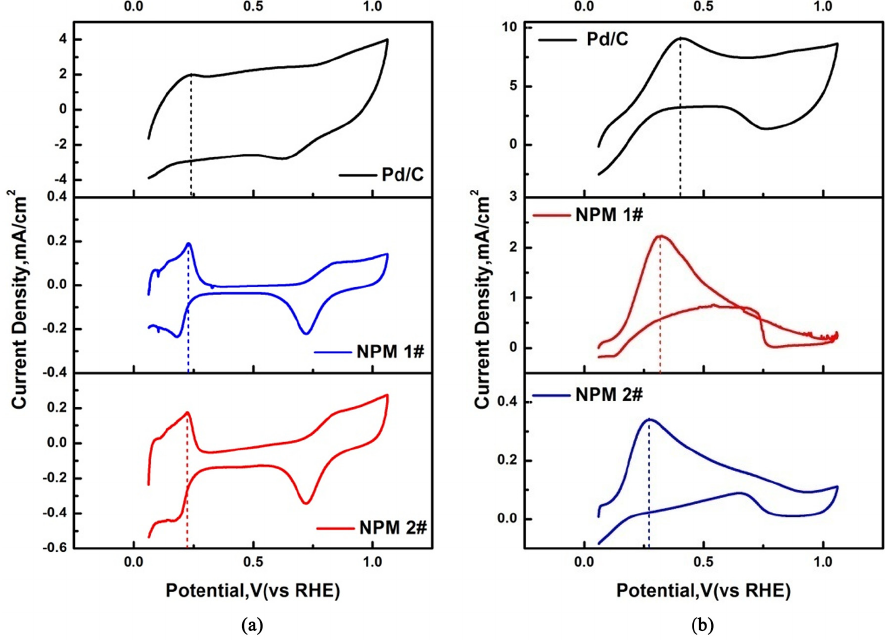
Figure 4. Cyclic voltammograms in 0.5 M H (vs